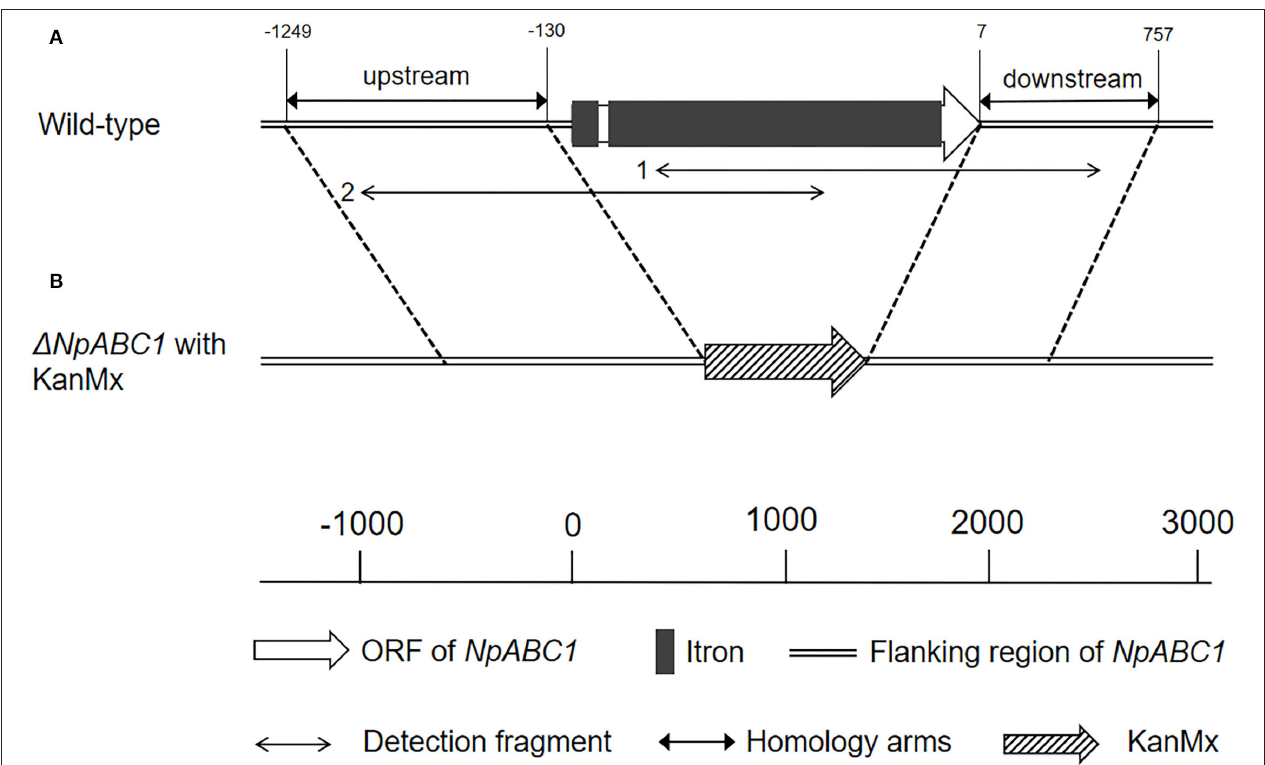
FIGURE 6 | Schematic of ABC1 gene structure and knockout. (A) Physical map of ABC1 in genomic DNA from N. parvum wild-type strain; (B) deletion mutant of NpABC1 with the G418-resistance (KanMx).